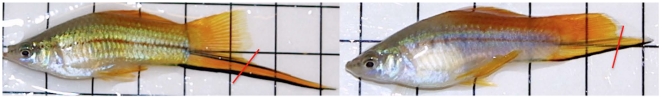
Variation in sword length.Two X. helleri males used in our study; one displaying an exceptionally long sword (left) and the other a very short sword (right), despite similar body lengths. Swords were removed at the point where the sword extends beyond the caudal fin, as indicated by the red lines.